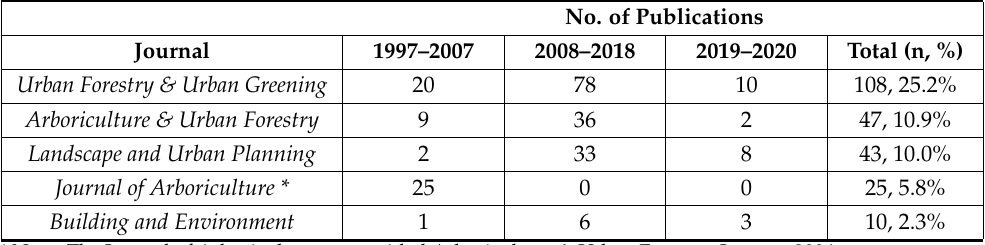
Table 2. Activity of top journals publishing street tree research over time.